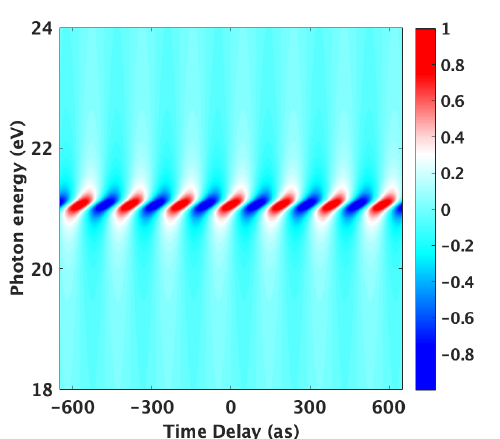
Figure 2. ATAS of a helium atom calculated using Equation